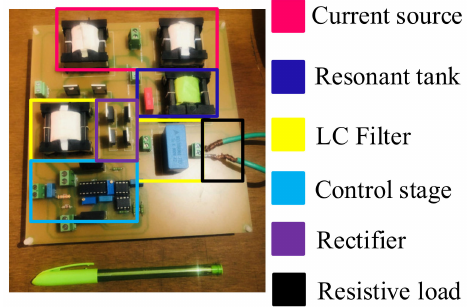
Figure 9. Current fed DC-DC resonant converter